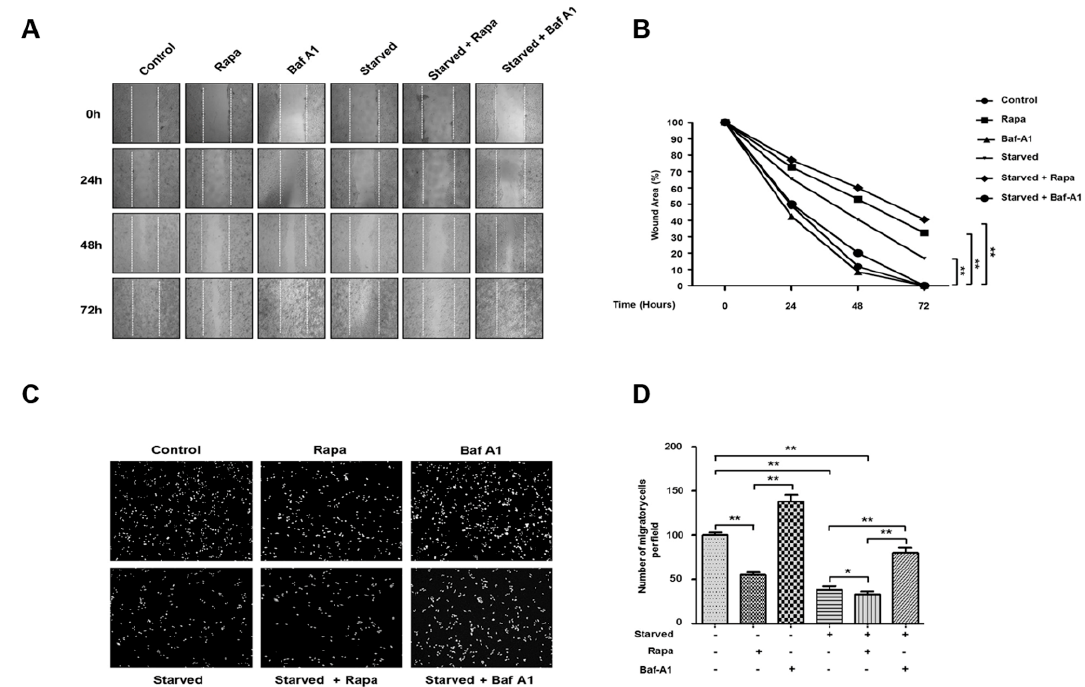
Figure 6. Autophagy inhibits migration of cancer cells. ( A , B ) HeLa cells were treated with either 100 nM rapamycin (Rapa) or HBSS to induce autophagy in the presence or absence of 10 nM bafilomycin A1 (BafA1). The migratory behavior of cancer cells under different conditions was determined by the wound-healing assay, as described in the methods, and representative images (50 × magnification) indicate cell migration at the times indicated. The wound edges at 0 h are indicated by white dotted lines. Cell migration ( B ) is represented as wound closure (percentage of the average migratory distance of cells relative to the original wound edge). Data indicate the mean ( ± S.D.) of at least three independent experiments (* p < 0.05 and ** p < 0.01). ( C ) The Matrigel invasion chamber assay using HeLa cells. Cells that invaded the transwell insert were stained with PI and photographed. ( D ) Cells were quantified in 10 randomly selected fields under a microscope (10 × objective magnification). Data represent the mean ( ± S.D.) of three independent experiments (** p < 0.01).